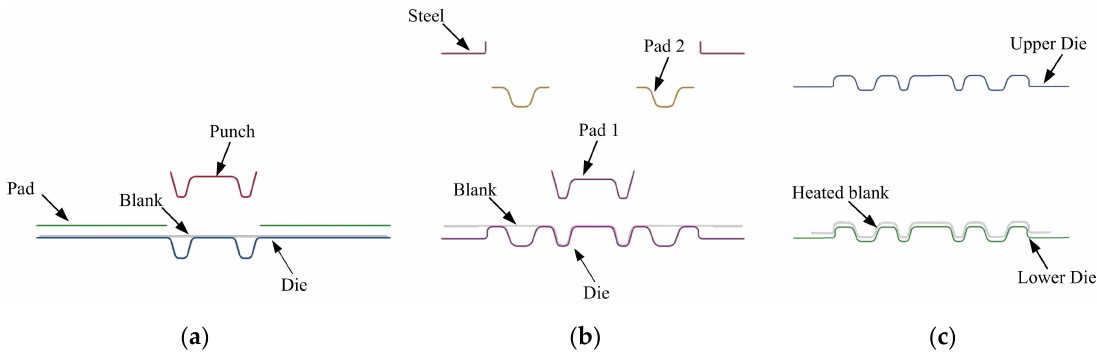
Figure 3. Finite element FE models of indirect hot stamping: ( a ) first stage and ( b ) second stage of pre-forming ( c ) hot stamping.